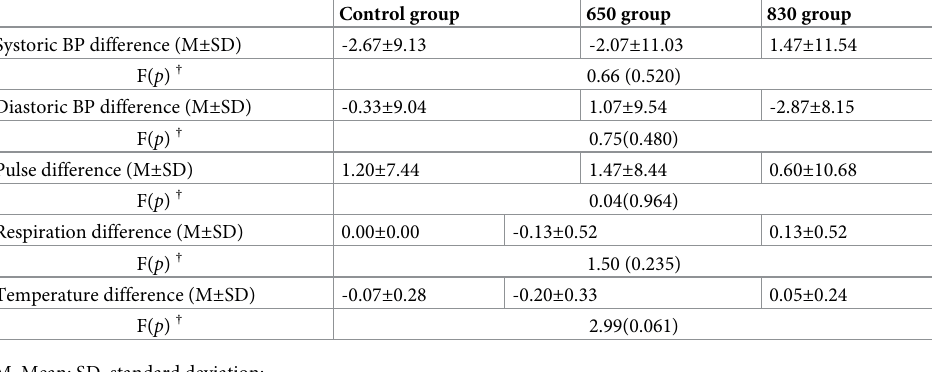
Table 7. Difference in changes in vital signs (Week4 vs. Week0) among three